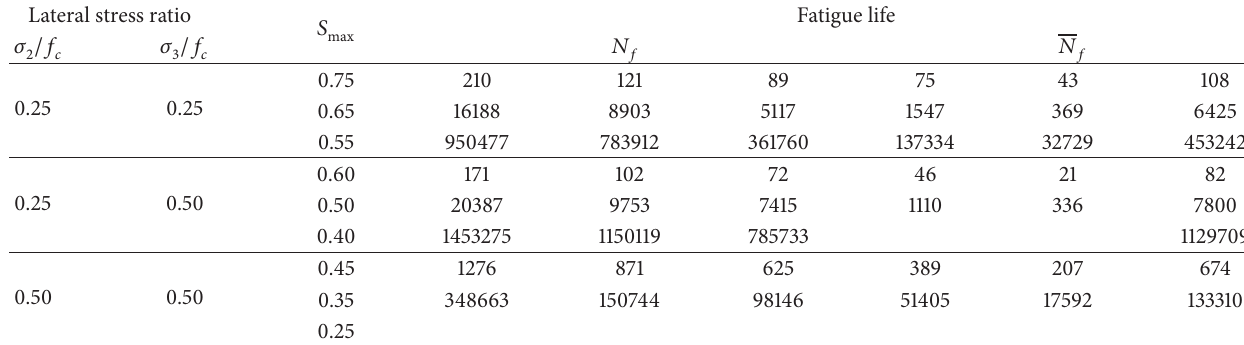
Figure 1: Machine and specimen. Table 1: Test results for constant-amplitude cyclic